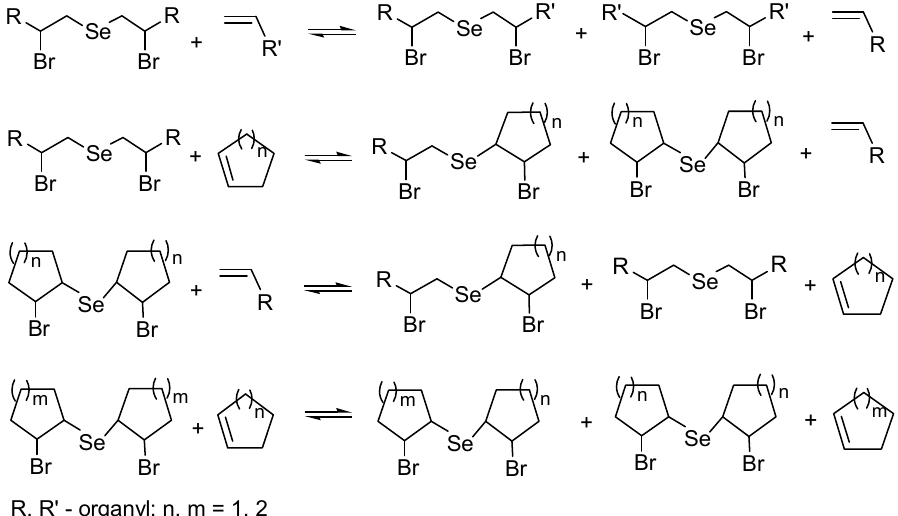
SeMeCN SeBr 2 + RT Scheme 3. The reaction of selenium dibromide with